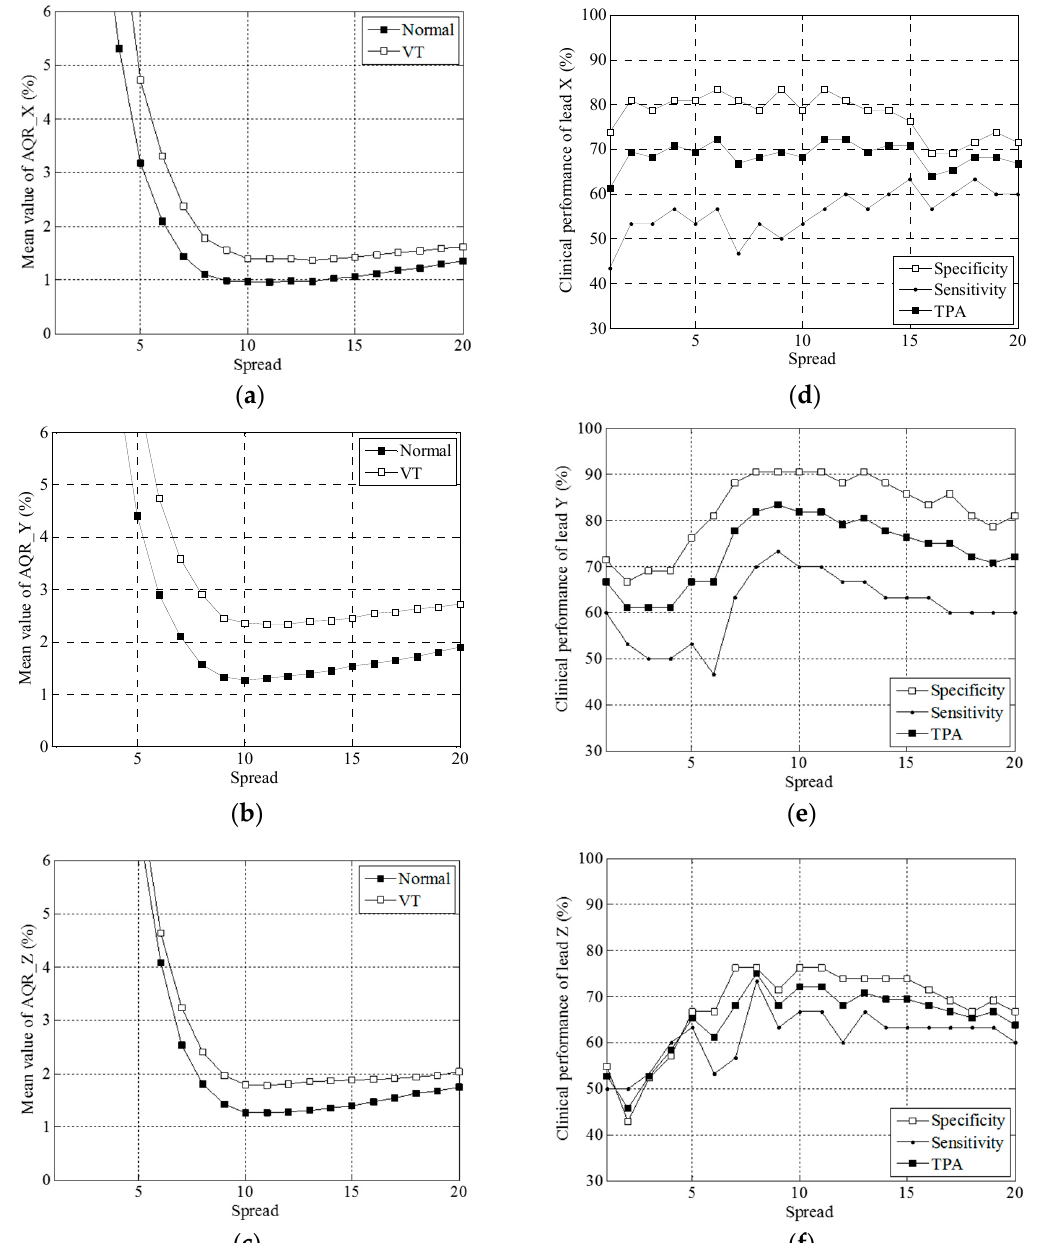
Figure 4. Graphs of the mean AQR vs. the spread parameter in leads ( a ) X; ( b ) Y and ( c ) Z and of the clinical performance vs. the spread parameter in leads ( d ) X; ( e ) Y and ( f ) Z, keeping the neuron number fixed at 10.